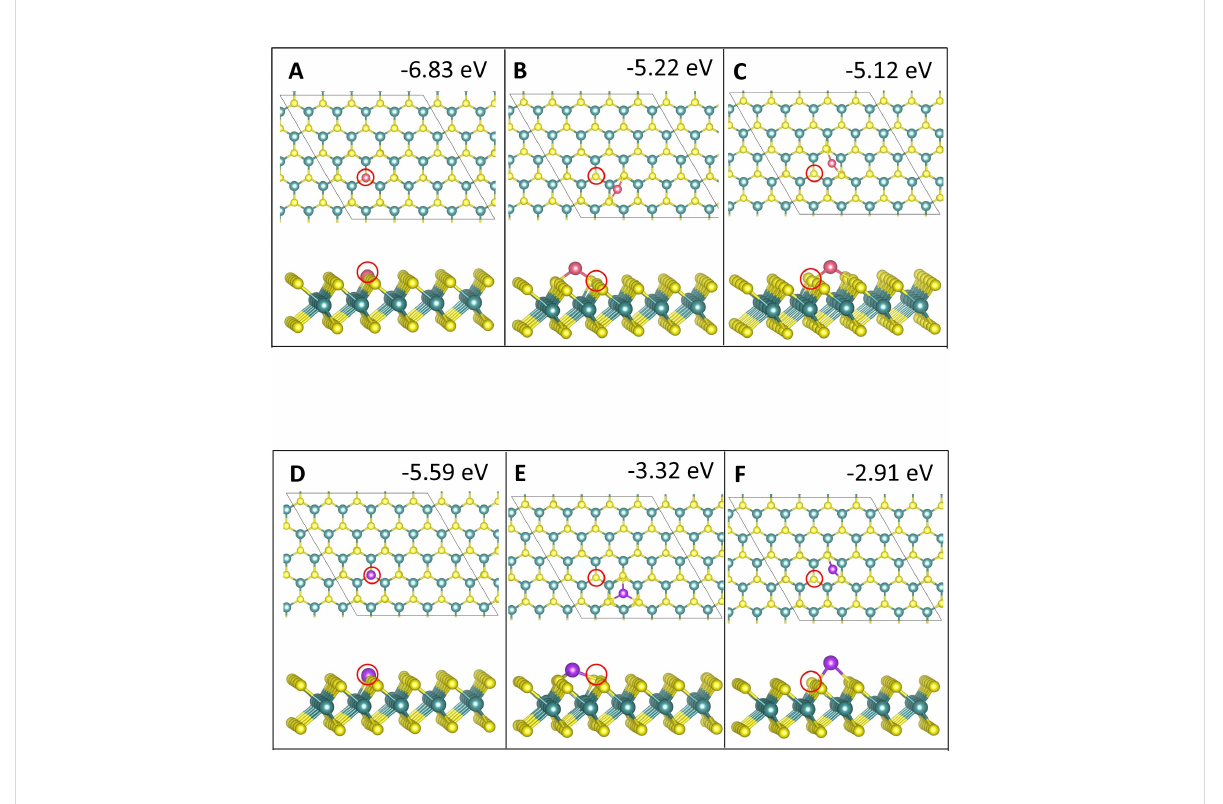
Figure 9: Adsorption modes of single Co (pink) and Ru (purple) atoms on defective MoS 2 . The red circle indicates the location of the S vacancy.